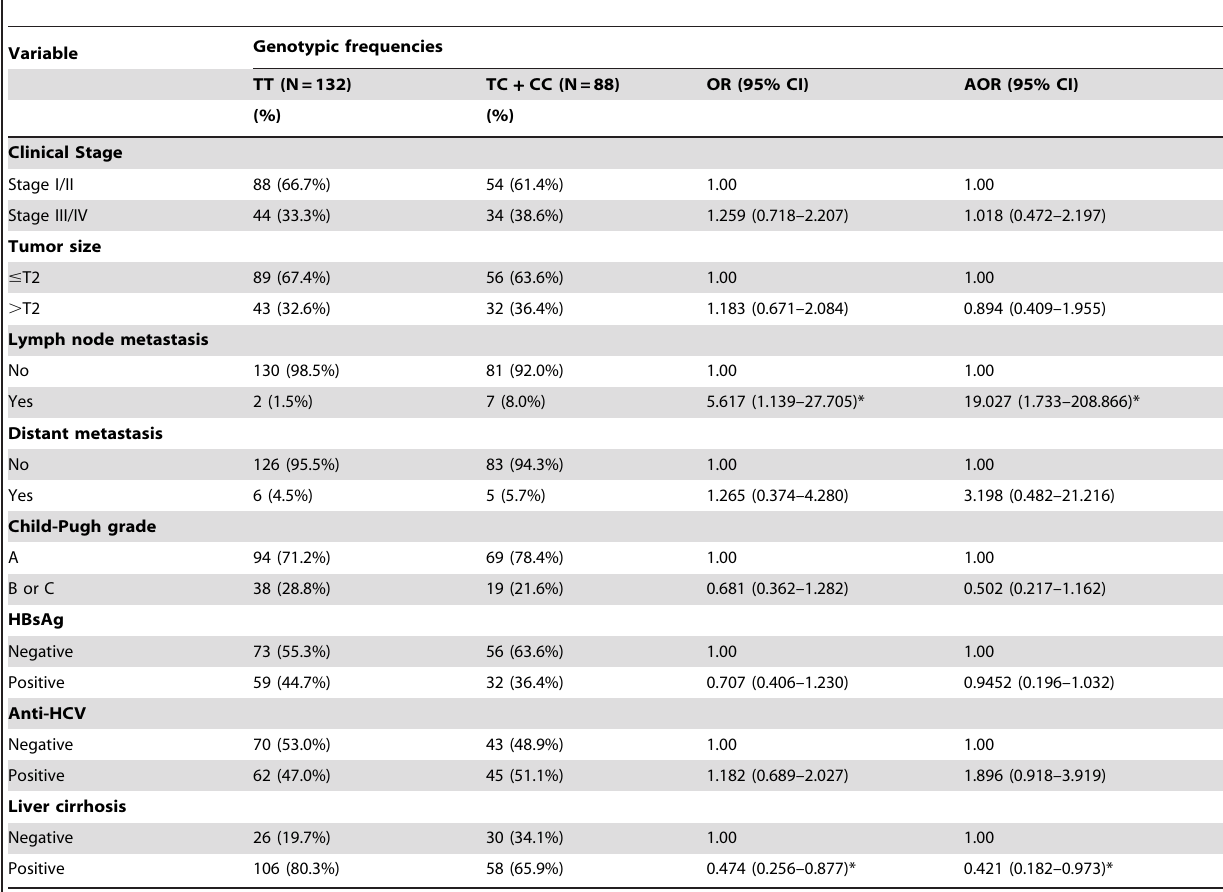
Table 3. Associations of clinical status and EZH2 rs6950683 genotypic frequencies in 220 HCC patients.